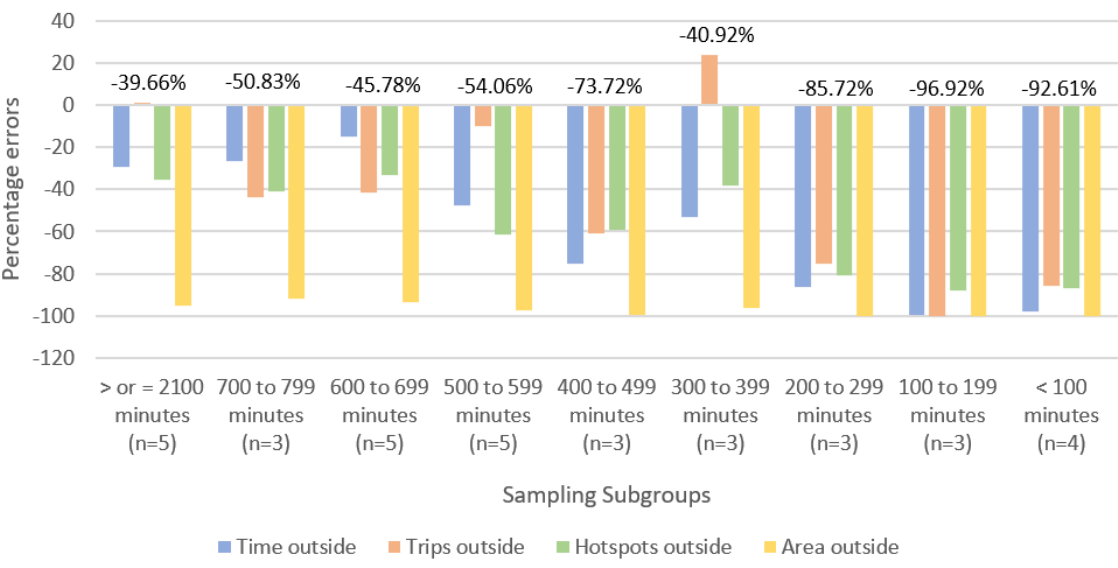
Figure 3. Mean percentage errors for all community mobility outcomes across different sampling lengths relative to sampling length of at least 7 days with 800 or more minutes. Mean percentage error rates for each sampling subgroup are listed above each cluster of bars. All shorter sampling subgroups yielded larger negative mean percentage errors, corresponding to greater underestimation of the ITV. Number of participants in each sampling length subgroup is indicated below the x-axis (n = 14).